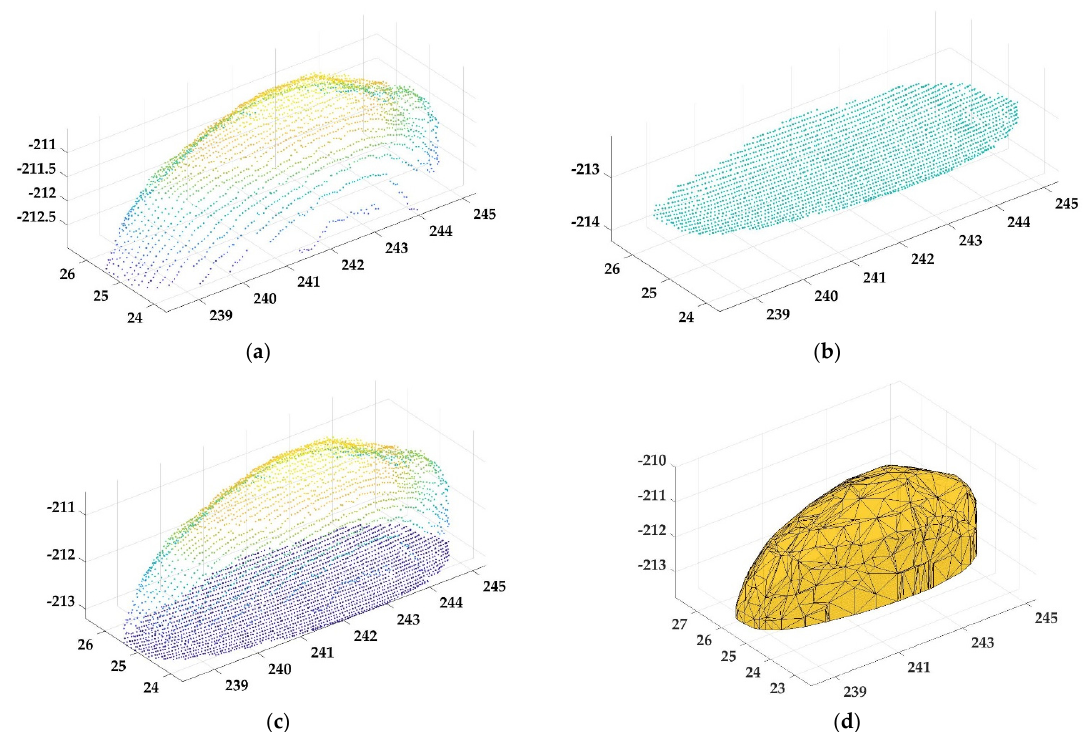
Figure 8. Complete grain 3D model construction. ( a ) Northeast view of the single − grain point cloud; ( b ) mapped grain bottom; ( c ) complete grain with bottom point cloud; ( d ) northeast view of the grain 3D model.